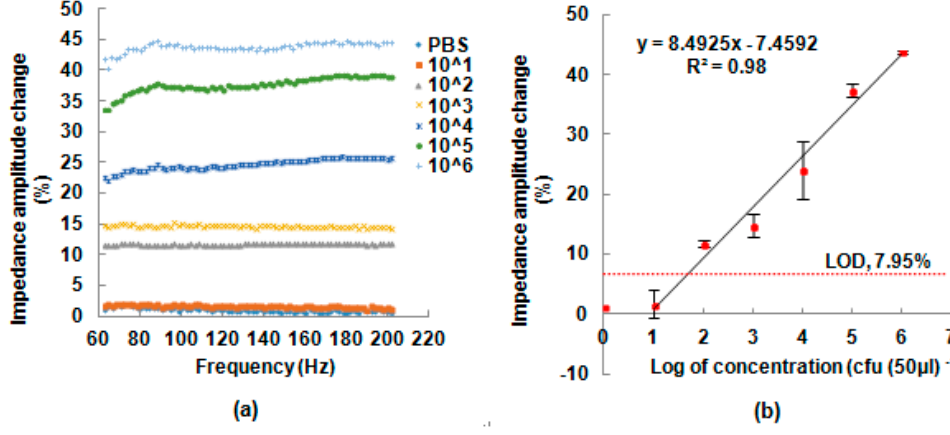
Figure 7. ( a ) impedance change of the negative control sample and concentrations of S . Typhimurium ranging from 10 1 to 10 6 CFU (50 μ L) − 1 in pure culture samples and ( b ) the relationship between the logarithmic value of the concentration of S . Typhimurium and impedance change at a frequency of 101 Hz. The means and standard error bars were determined using three replications. Table 1. Results of paired samples t -tests of the negative control sample and different concentrations of S . Typhimurium in pure culture samples.